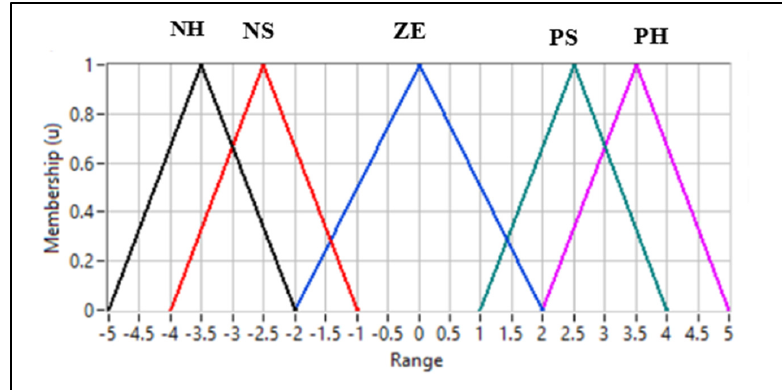
Fig. 3. membership function of the system control. Selecting the range of membership depends on the design of the control